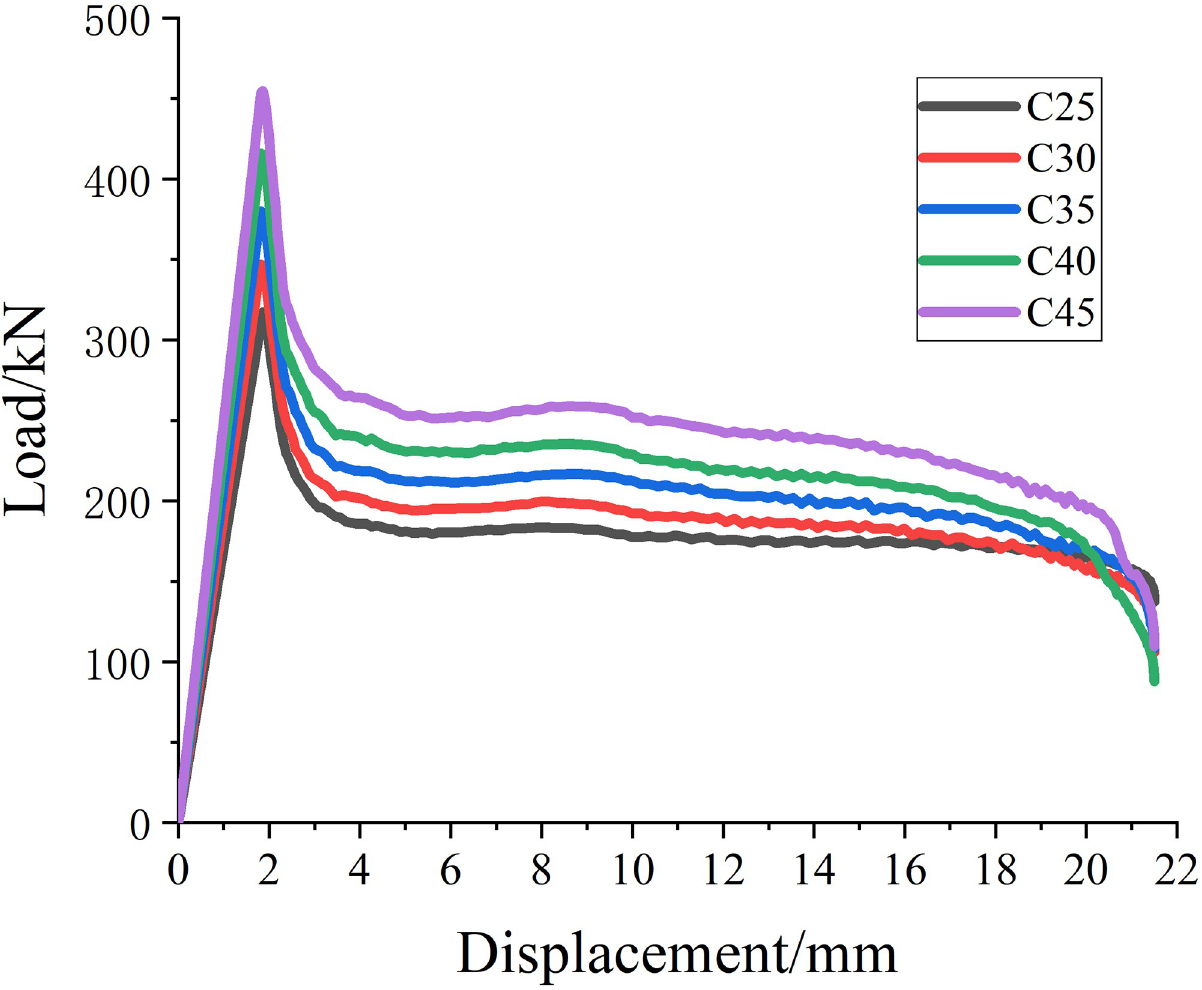
Fig 19. Load—Displacement curve of reinforcement parts with different concrete strength.